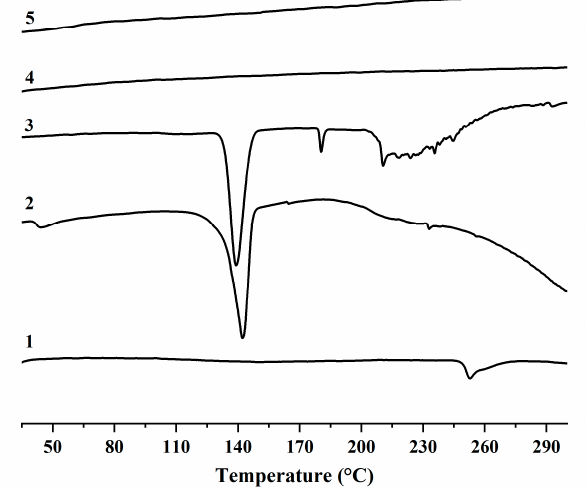
Figure 3. DSC thermograms of quercetin (1), cholesterol (2), glucose monolaurate (3), plain niosomes (4) and quercetin loaded niosomes (5).